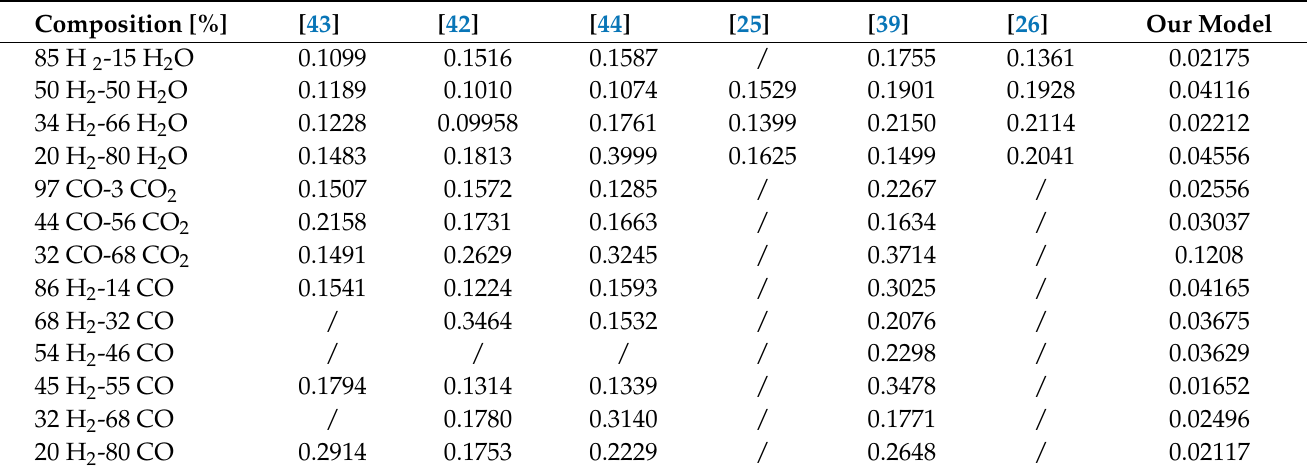
Table 3. Comparison of RMSD values for individual polarisation curves obtained with known system level models of similar modelling depth from the